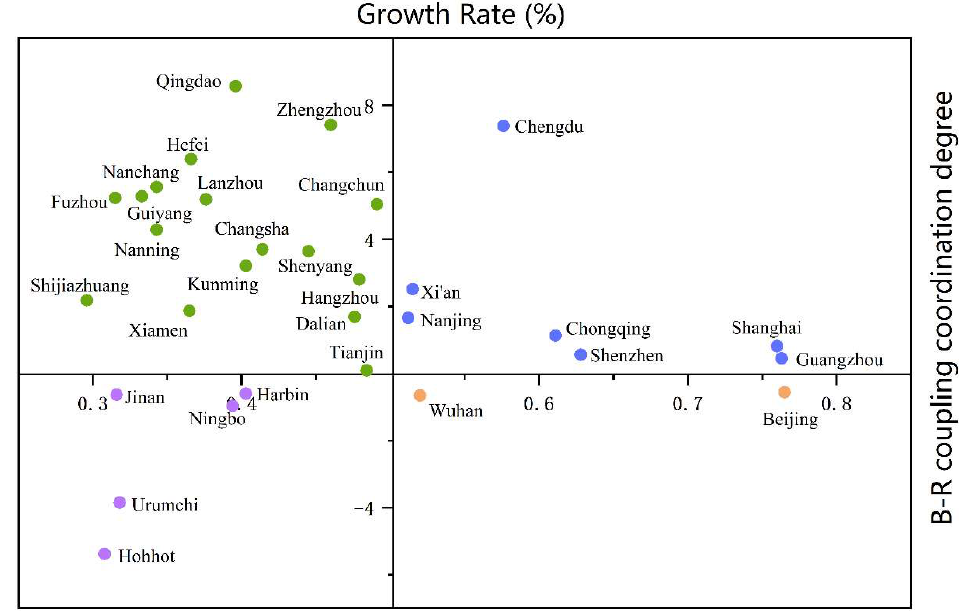
Figure 7. Coupling coordination relationship of B-R in 31 cities in China.